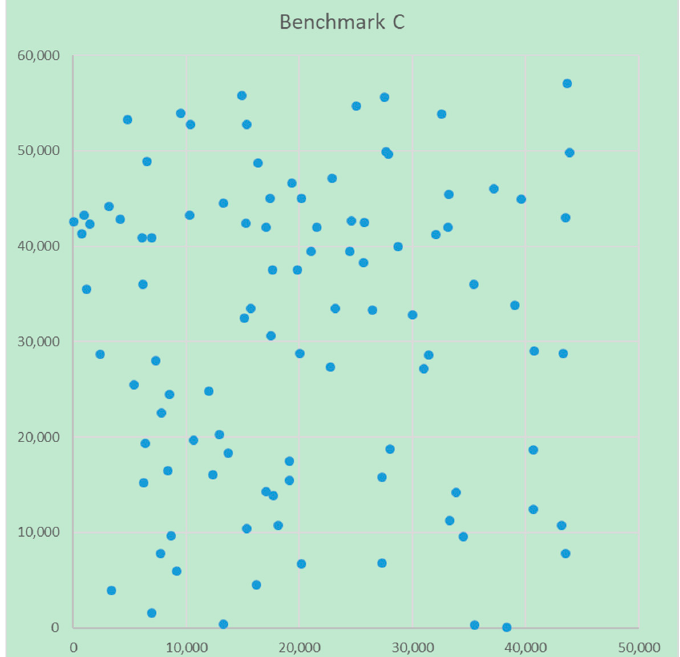
Figure 2. Benchmark instance B.